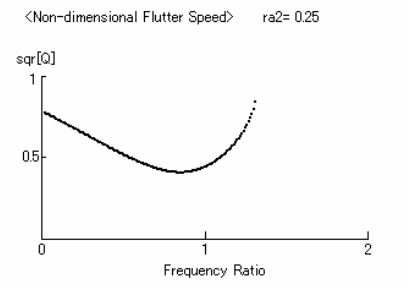
Fig 2. Deterministic flutter boundary It shows the dependency of the flutter speed on the frequency ratio R. The upper region above the boundary corresponds to the unstable area, i.e. flutter. The boundary becomes the lowest just before one as the frequency ratio increases. The result is reasonable if you think of the coupling between the two degrees of freedom to cause flutter. It may be interesting to compare these results with those of equation (5) for the low frequency ratio. The substitution of the condition, R=0 into equations from (19) to (21) yields